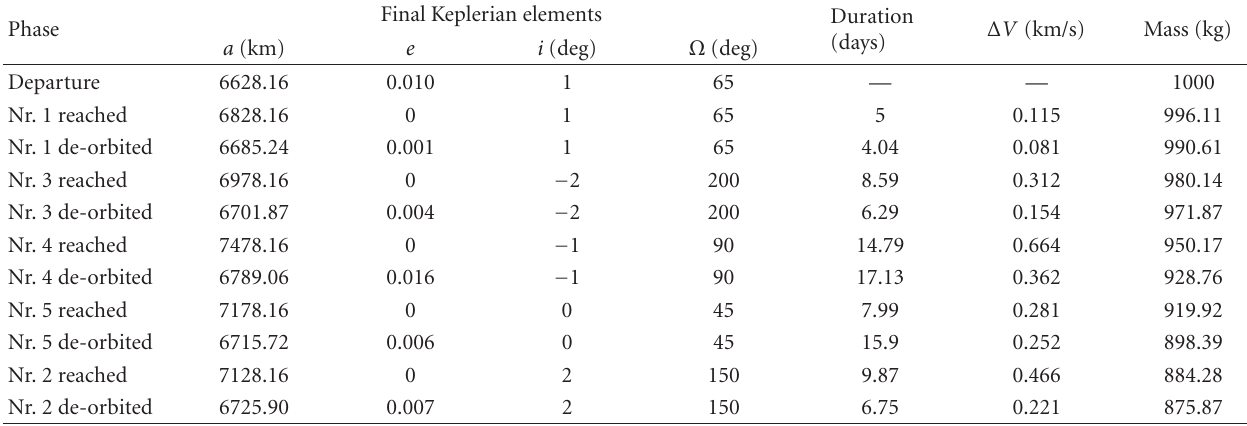
Table 9: Debris removal sequence and timing for minimum TOF Tot .